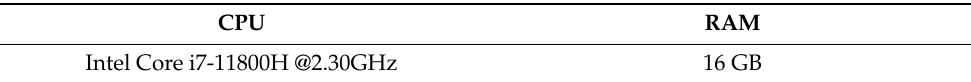
Table 6. Computer specifications used for the proposed